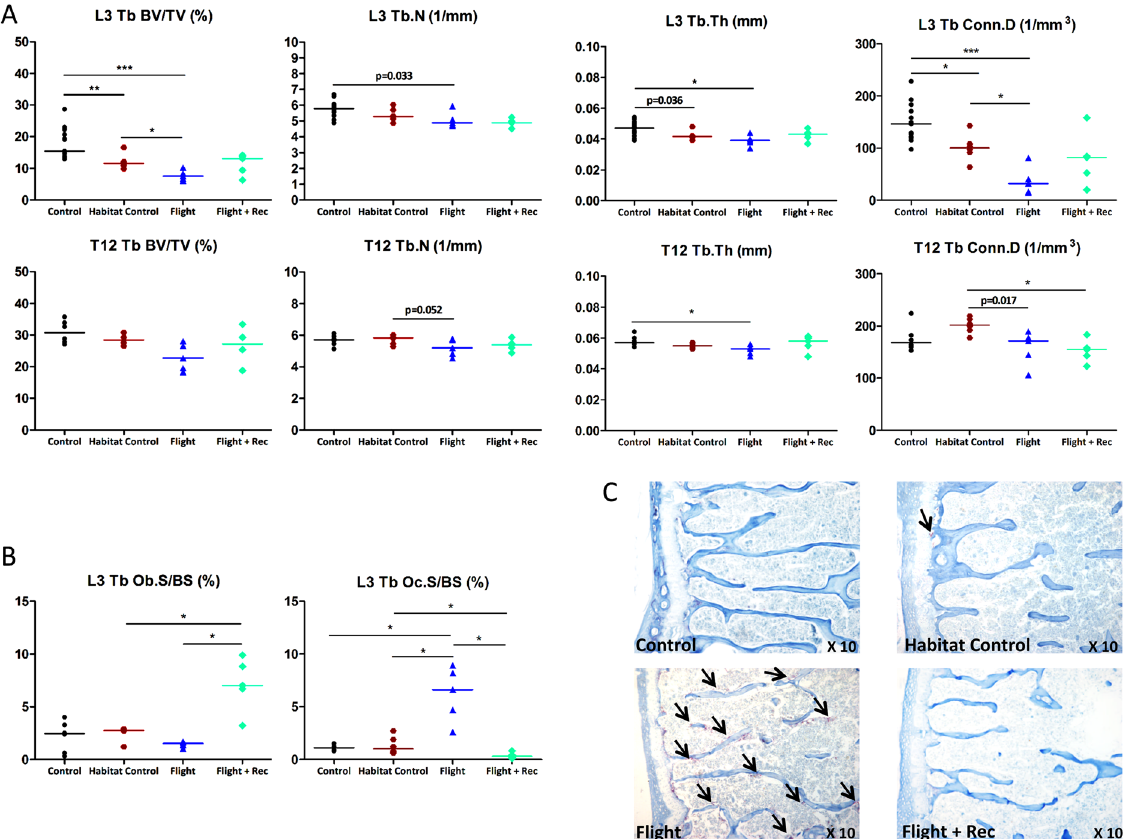
Figure 2. Effects of spacecraft housing conditions, spaceflight and recovery on ( A ) L3 and T12 vertebrae microarchitecture parameters, ( B ) trabecular osteoblast surfaces (Ob.S/BS) and osteoclast surfaces (Oc.S/BS). ( C ) Tartrate resistant acid phosphatase staining of osteoclastic cells (black arrows). Trabecular (Tb) parameters include bone volume fraction (BV/TV), trabecular number (Tb.N), trabecular thickness (Tb.Th), and connectivity density (Conn.D). Data are presented as clusters of individual points (bars = median). * p < 0.017, ** p <